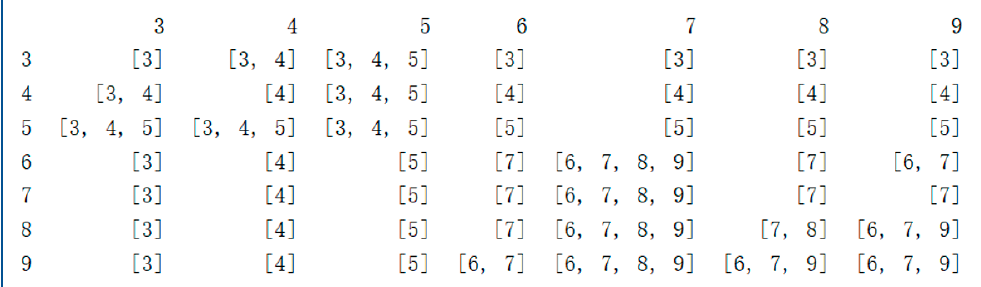
Figure 11. New lower right (running result of Python).